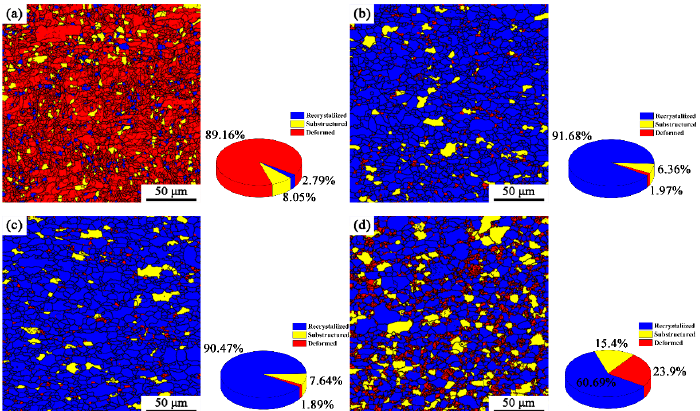
Figure 4. Recrystallization microstructure distribution of X2CrNi12 steel at different annealing tem- peratures with 90% cold-rolling deformation ( a ) deformed; ( b ) 720 °C; ( c ) 740 °C; ( d ) 770 °C.